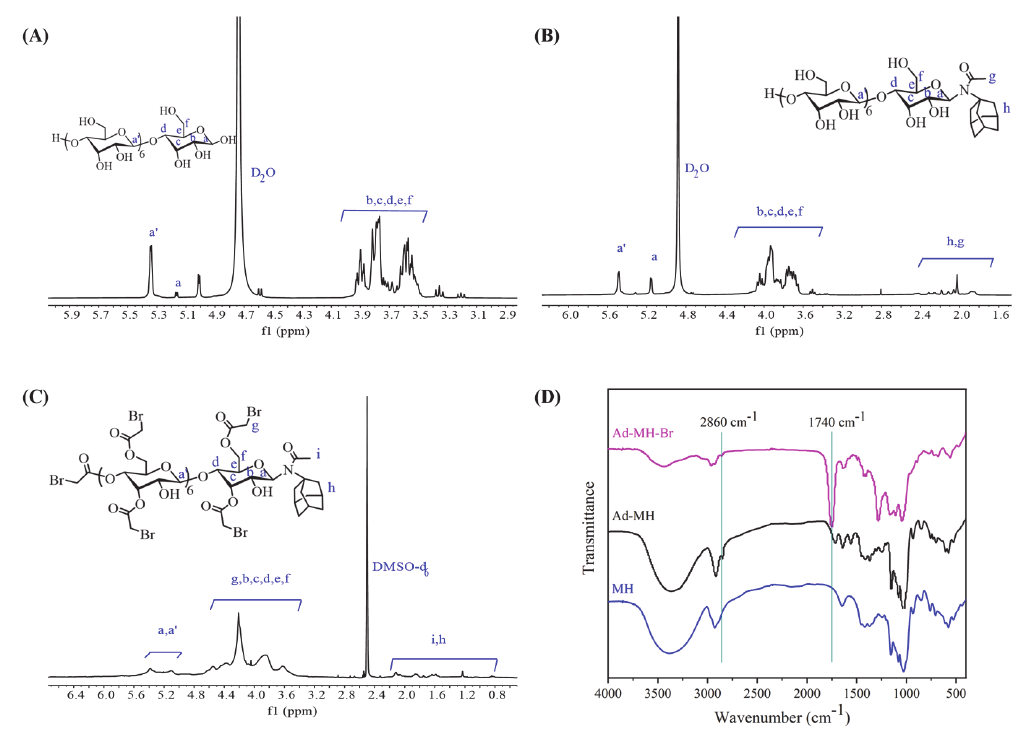
Figure 3. Synthetic route for Ad-MH-NO.